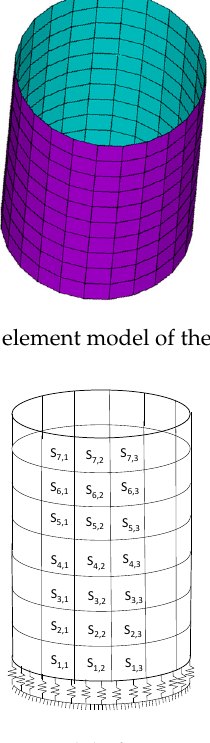
Figure 23. Natural frequency domain response of acceleration and pulse load. ( a ) The first mode shape ( b ) The second mode shape Figure 24. The first two mode shapes of the liquid storage tank. Using the values of the first three natural frequencies of the tank obtained from the experiment, the vertical rubber stiffness is modified to ensure the consistency between the experimental data and finite element results. The minimum relative error is reached when the spring stiffness is 9 (cid:3400) 10 (cid:2874) N/m . The natural frequency results are shown in Table 2. The maximum error is found to be 2.00 % between the experimental model and the theoretical model, indicating that the tank FE model,